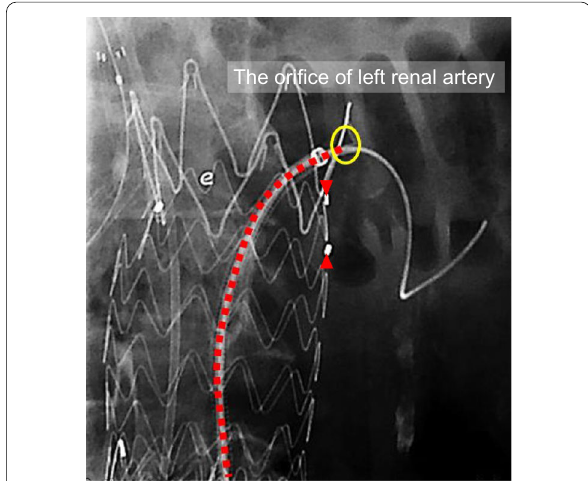
Fig. 2 The left renal artery cannulation was done via the trans-femoral access because it was difficult through the trans-brachial access due to interference of the supra-renal stent of the previous Endurant II stentgraft. The ring maker indicates the orifice of the left renal artery and the arrowhead indicates the fenestration to the left renal artery. The ring maker indicates the orifice of left renal